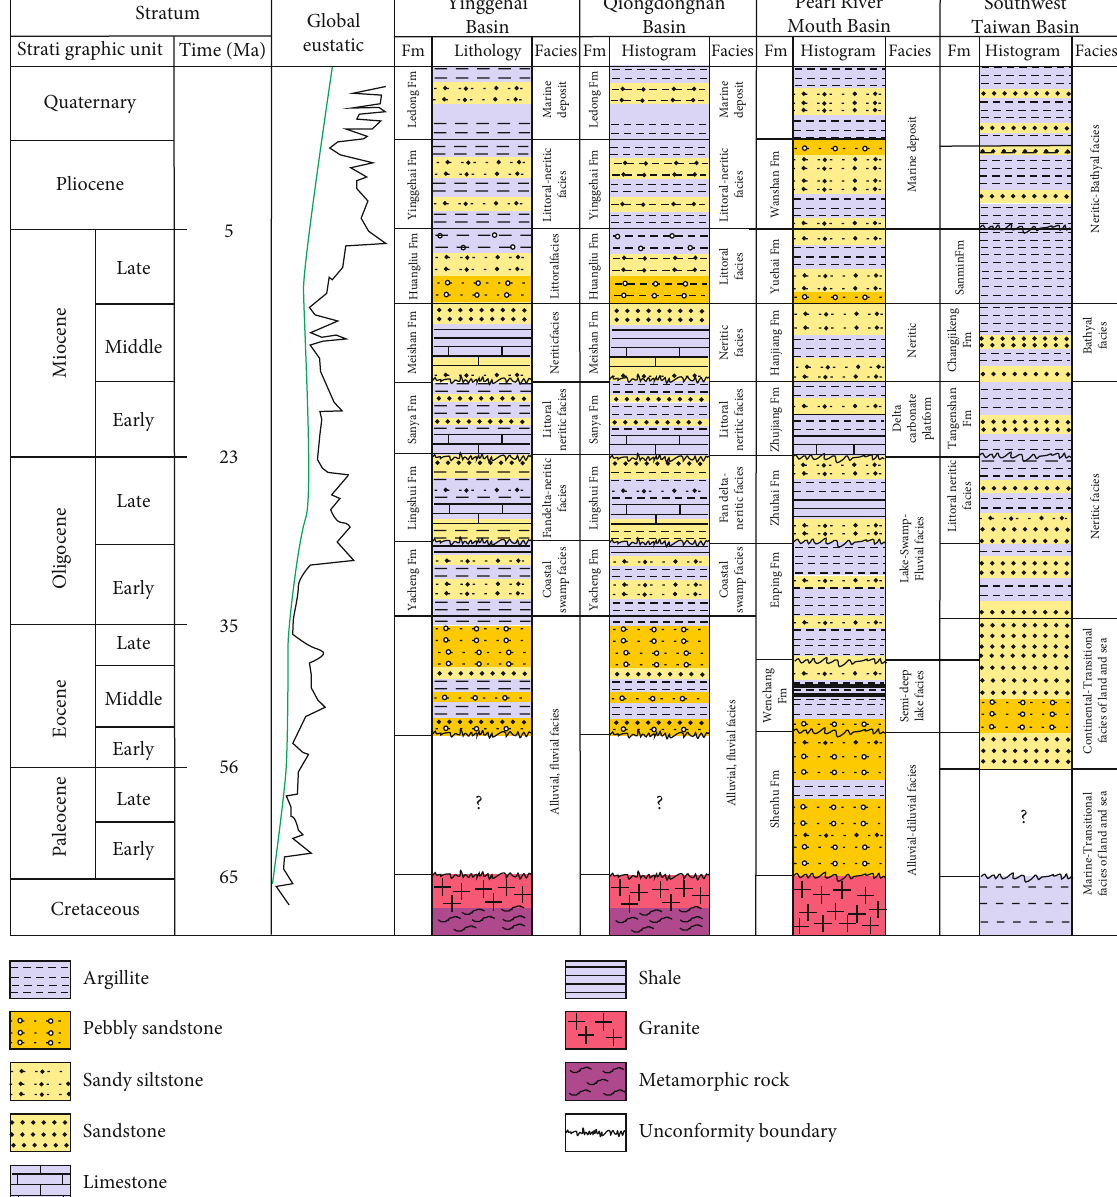
Figure 2: Stratigraphic integrative column map of basins in the northern margin of the South China Sea (modi fi ed from